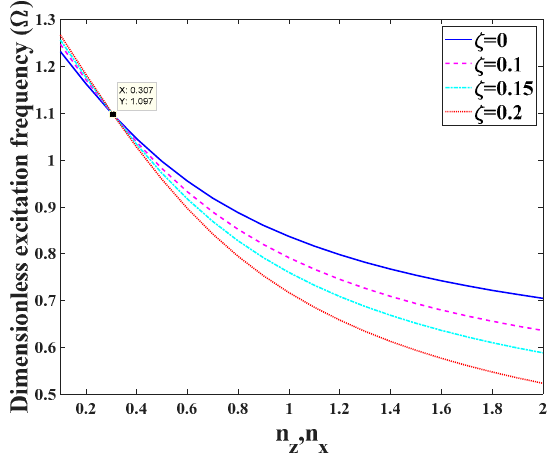
ζ on the dimensionless excitation frequency